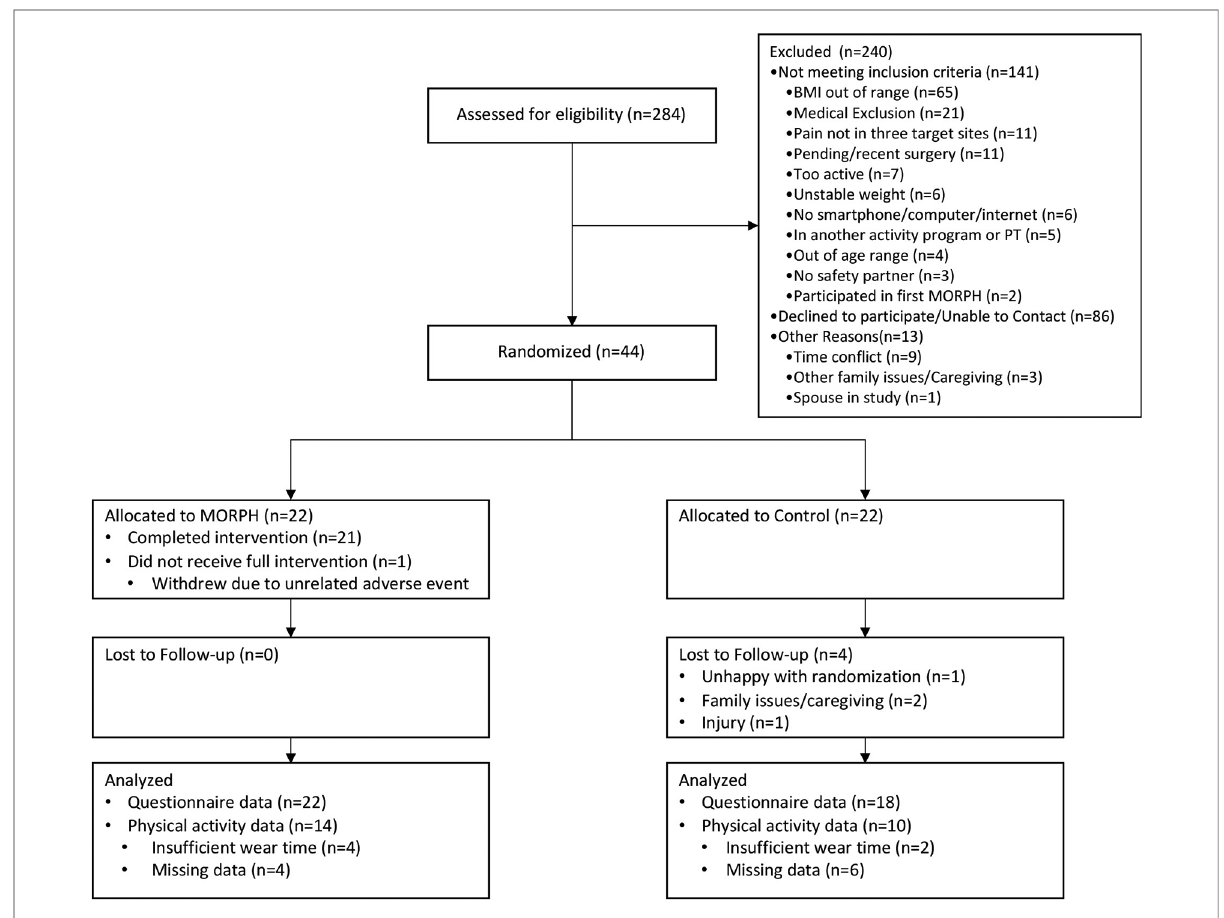
FIGURE 3 CONSORT diagram.